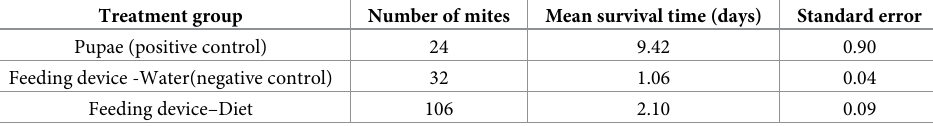
Table 1. Survivorship data for mites from trials with artificial diet and positive and negative